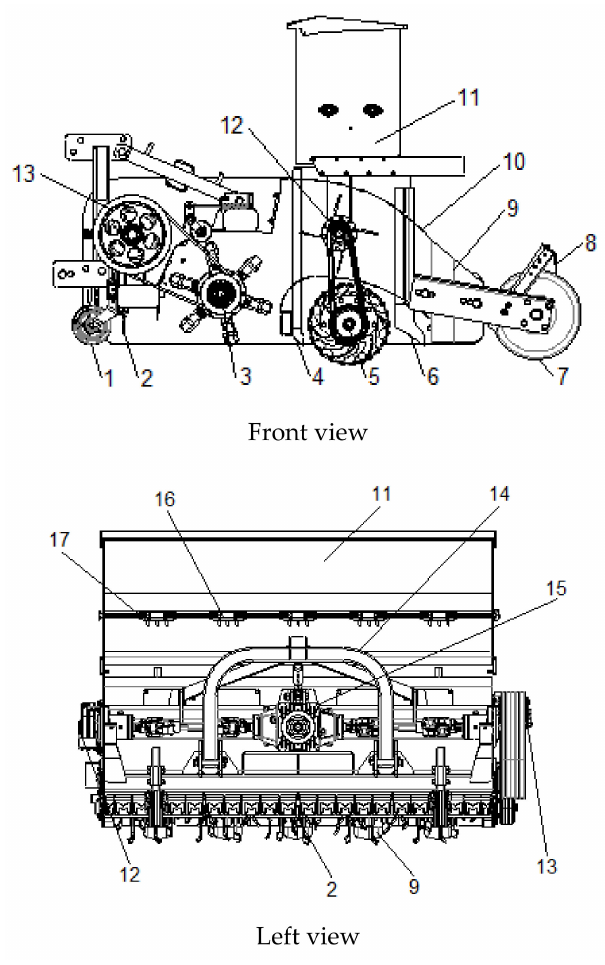
Figure 1. Structure of strip fertilization planter for straw back throwing and inter-row